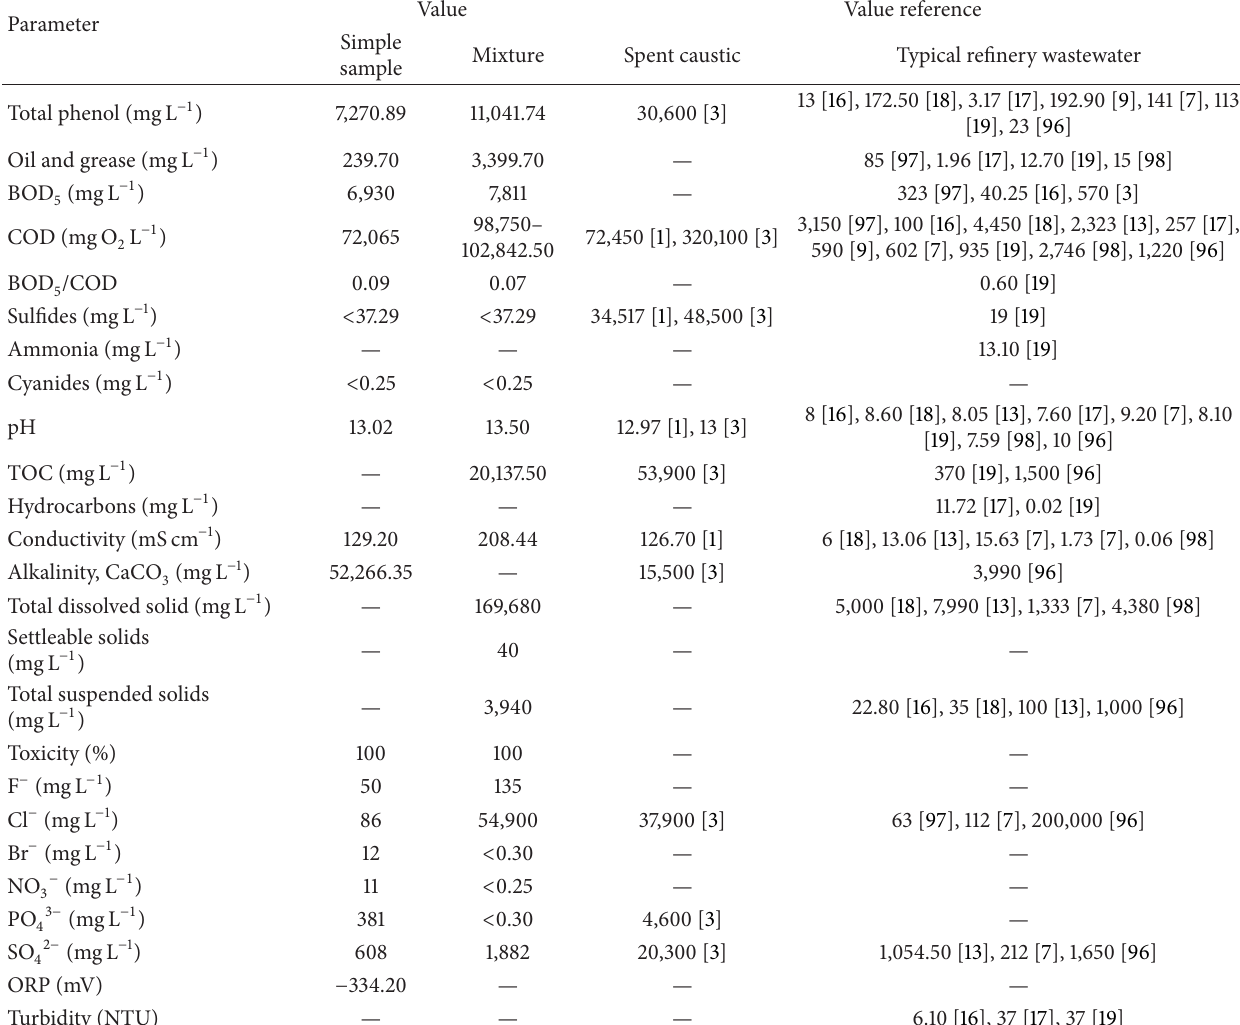
Table 1: Physicochemical analysis of spent